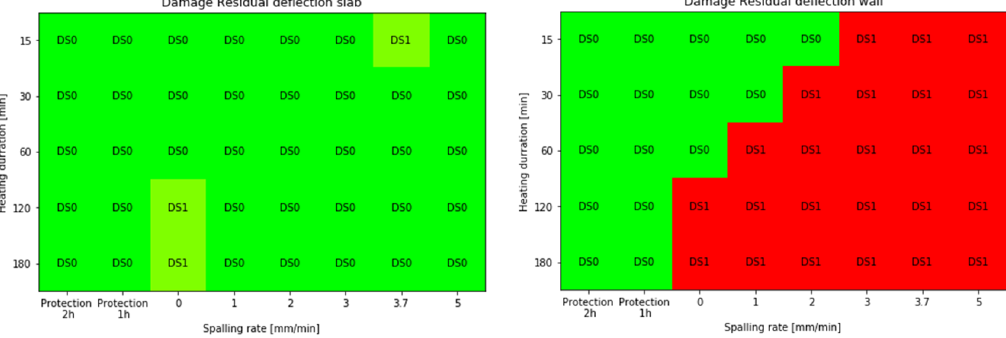
Figure 8. Structural damage state (ceiling and wall) in function of RWS heating phase duration and nominal rate of concrete